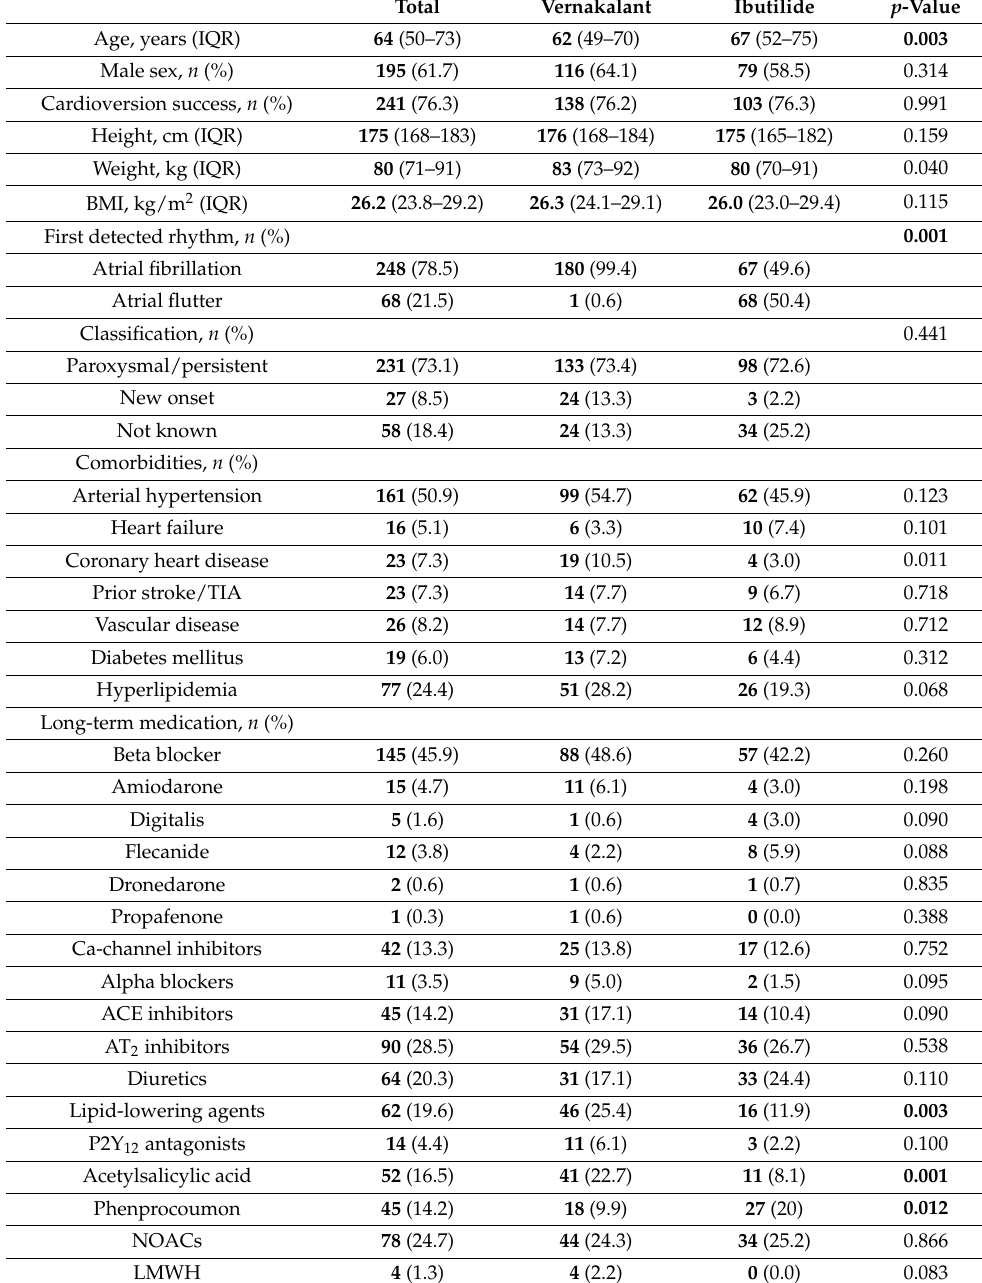
Table 2. Baseline characteristics for the total